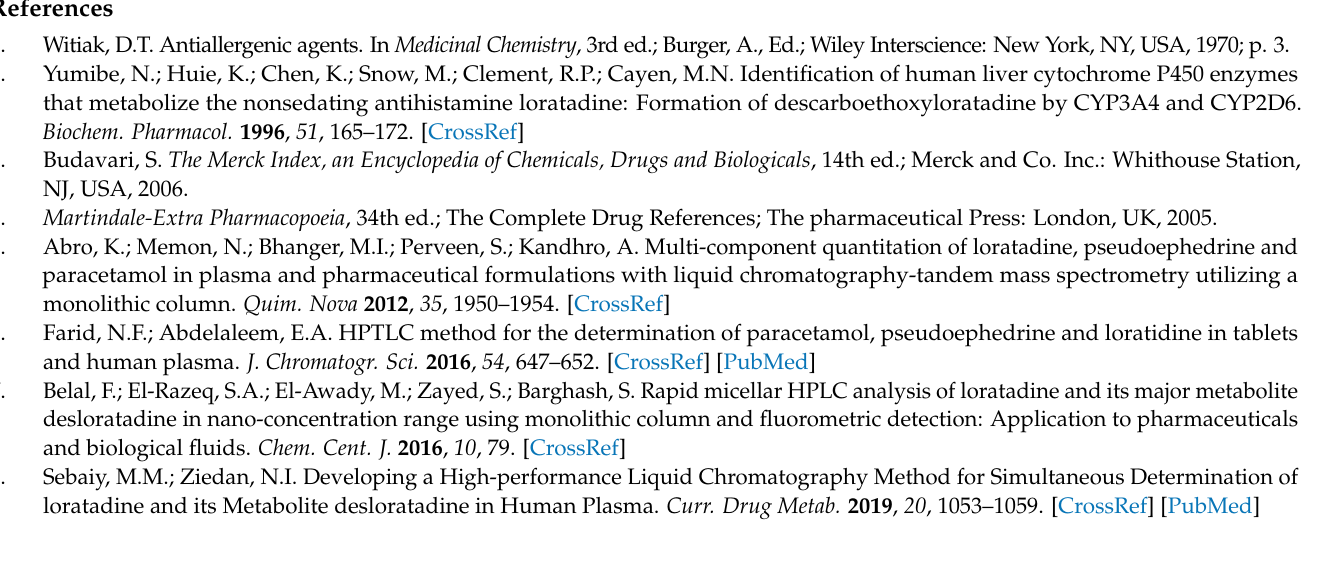
Figure S4. Calibration curves for the analytes for MS method; Table S1: the produced random runs for screening and optimization; Table S2. Robustness testing for the developed HPLC